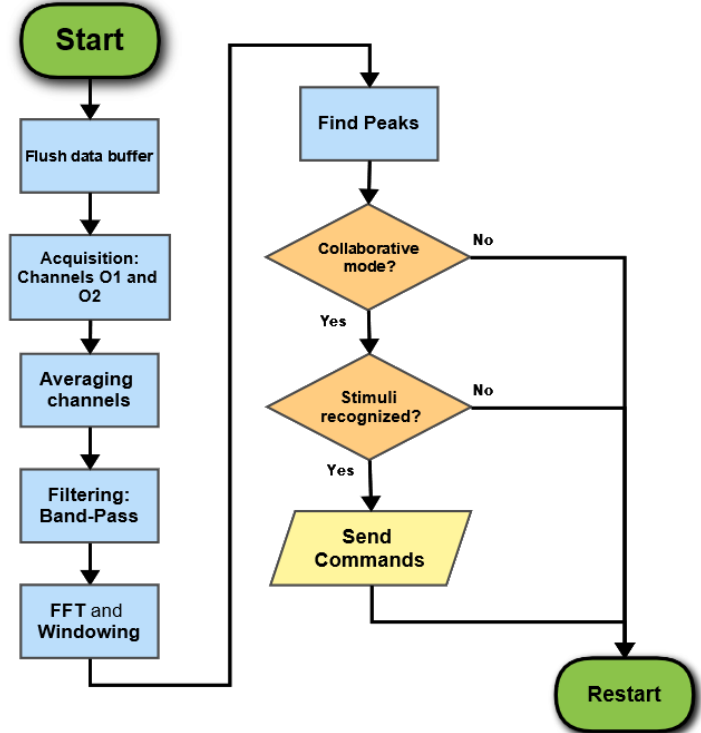
Figure 5. SSVEP frequency recognition software